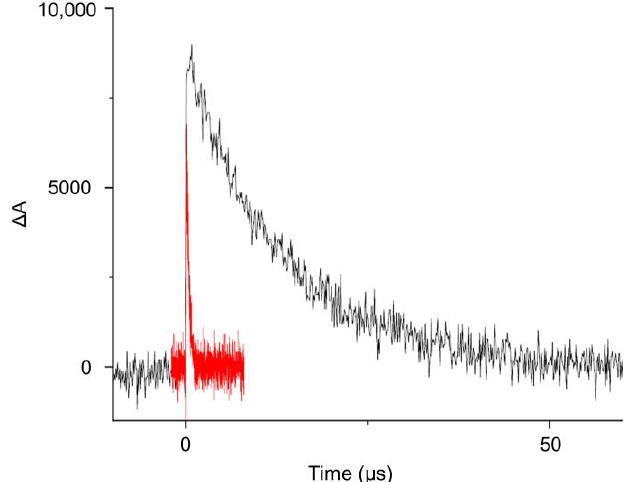
Figure 9. Transient absorption traces recorded at 470 nm upon LFP excitation (532 nm) of [Ru(bpy) 3 ] 2+ in the presence of 1a (4.7 · 10 − 3 M) in deoxygenated (black) and oxygenated CH 2 Cl 2 (red).